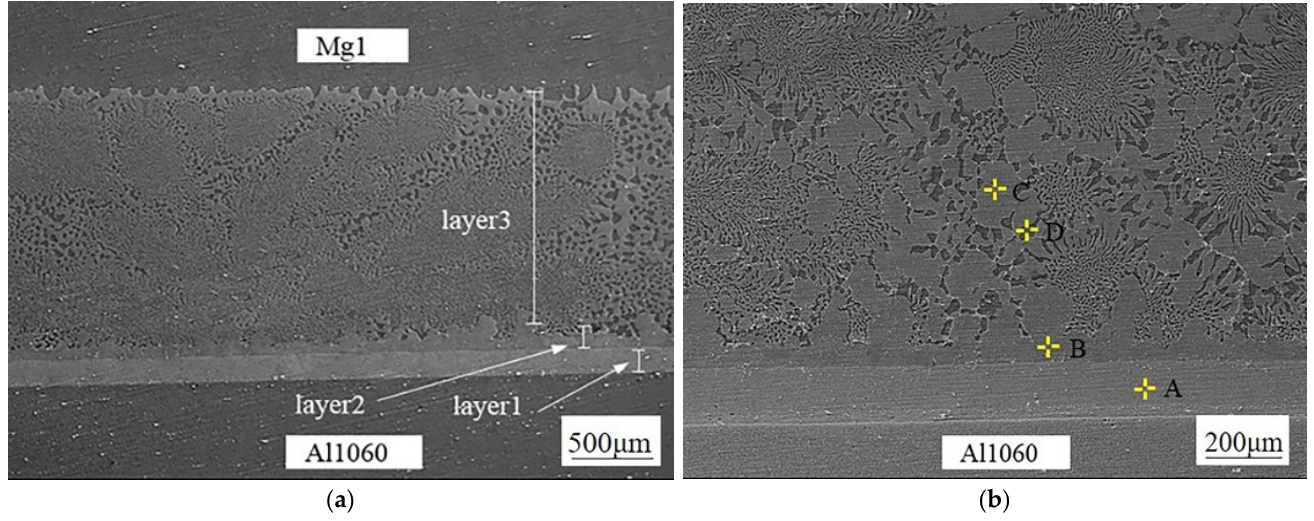
Figure 2. SEM images of the Mg1/Al1060 diffusion layers: ( a ) SEM image at low magnification, ( b ) SEM image at high magnification.